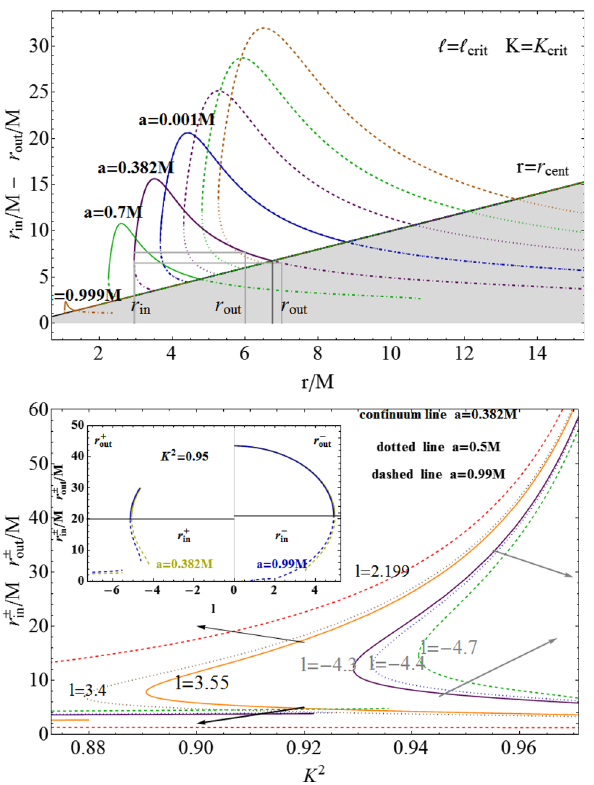
Fig. 6 Upper panel : plots of the inner r in and outer r out edges of RADs accretion tori orbiting different SMBHs (spins a on curves), as functions of r / M . r in and r out are introduced in Eq. (14). Shaded region is r < r cent , r cent is the line of torus centers where at fixed r / M there is r cent = r . Corotating tori are represented in continuum and dotdashed curves, thick dashed and thick dotted curves are for counterrotating tori. Horizontallinesoneachcurvefixatorus(constantangularmomentum), torus inner and outer edges are signed on the figure – see discussion on Eq. (14). Bottom panel : inner r ± and outer edges r ± out of accretion torus, in at different spins and fluid specific angular momentum for corotating ( - ) andcounterrotating( + )fluids. asfunctionsof K 2 where K ∈ [ K mso , 1 [ . Arrows follow increasing values of the SMBHs spins. Inside panel: and edges r ± out as functions of specific angular momentum (cid:4) , radii r ± in for corotating and counterrotating fluids, for SMBH spins a = 0 . 99 M and a = 0 . 382 M at K 2 = 0 .